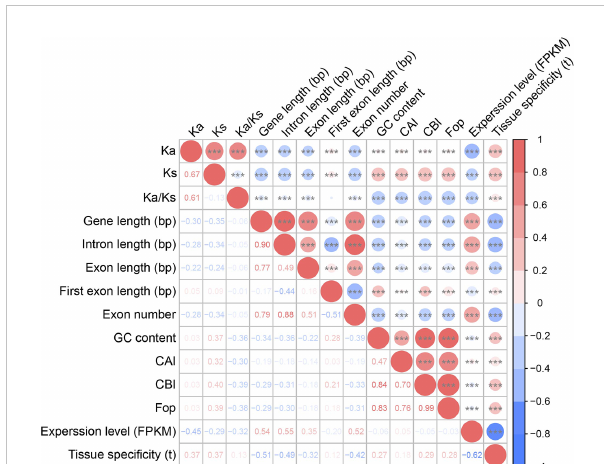
FIGURE 4 Correlations among substitution rates, gene features, codon usage bias, and expression patterns. The Ka, Ks, and Ka/Ks values were calculated between barley and rye. Upper right: the size of the circle represents the magnitude of the correlation coef fi cient, red indicates positive correlation, and blue indicates negative correlation. Three asterisks (***) indicate 0.001 signi fi cant difference level. Bottom left: correlation coef fi cients are presented as two- sided Spearman ’ s rank correlation test r